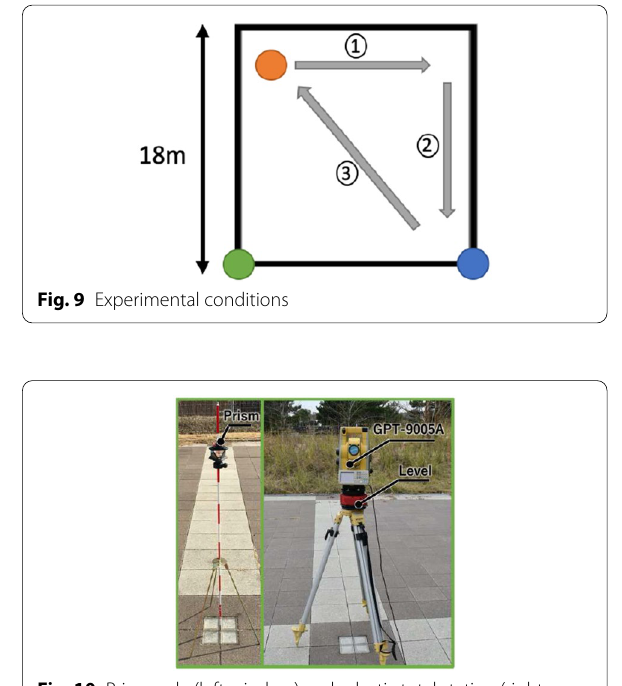
Fig. 10 Prism pole (left window) and robotic total station (right window)